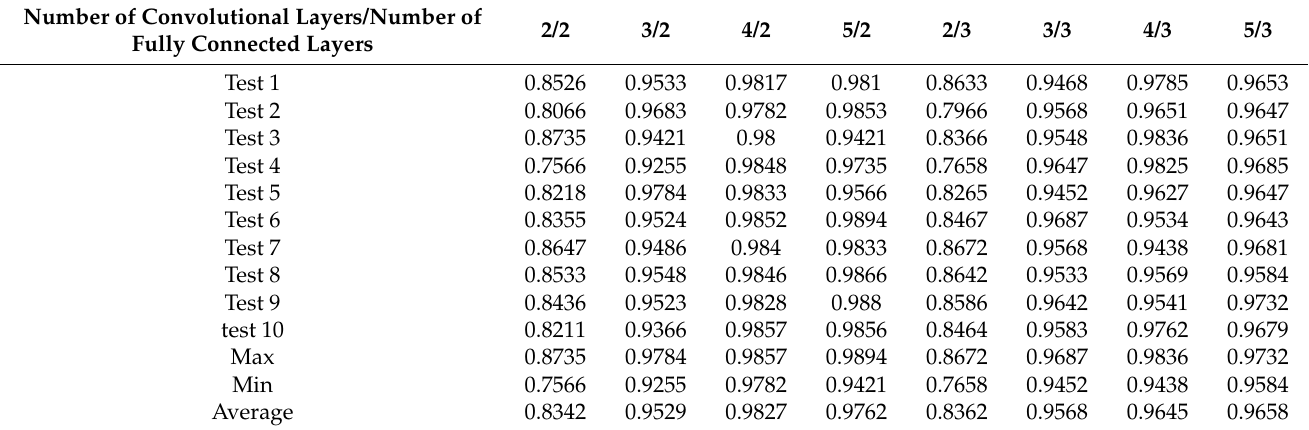
Table 1. The diagnosis results with different networks.